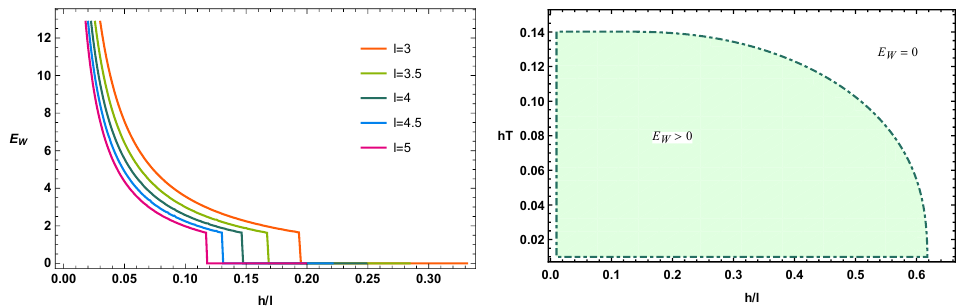
Figure 2 . Left : E W in AdS-Schwarzschild black brane as a function of h=‘ for di(cid:11)erent values of ‘ . Right : parameter space for d = 3 where E W is nonzero only in the shaded region. Here we have set r h =